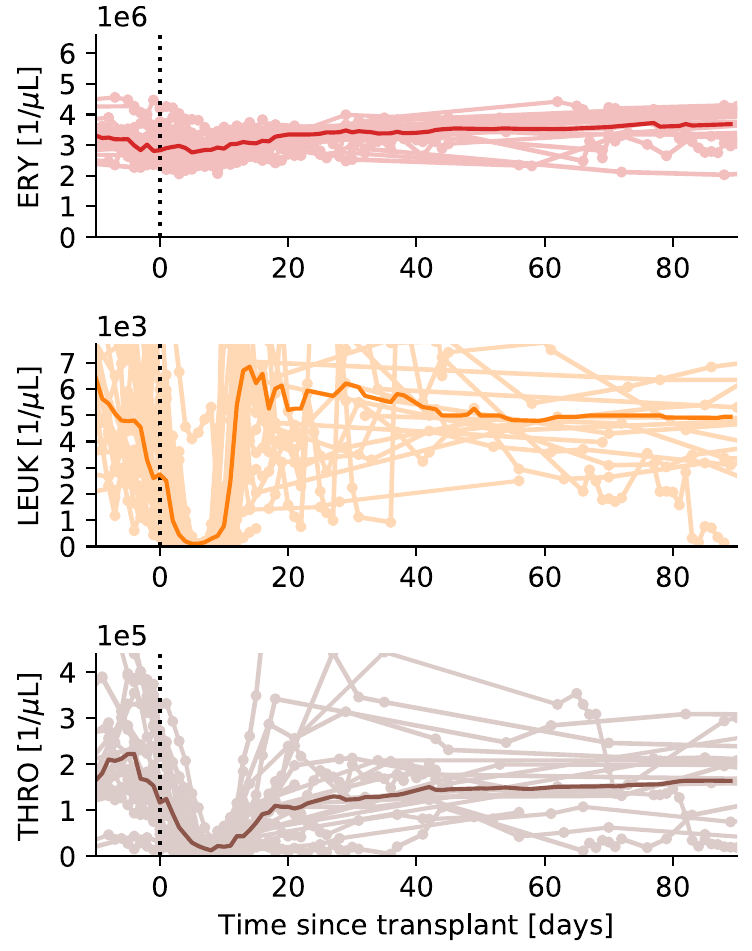
Fig 4. Clinical data from autologous stem cell transplants. The erythrocyte, leukocyte, and thrombocyte counts for 24 lymphoma patients around the time of their stem cell transplant are shown. The faint colors depict the individual patients with dots denoting actual measurements. The bold colors depict the median time-courses of linear interpolations of the single-patient data.